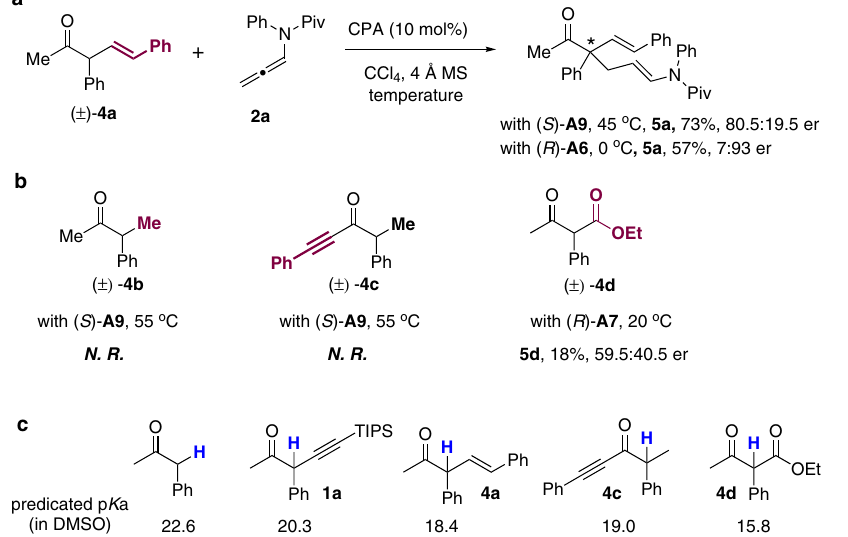
NATURE COMMUNICATIONS| (2021) 12:6700